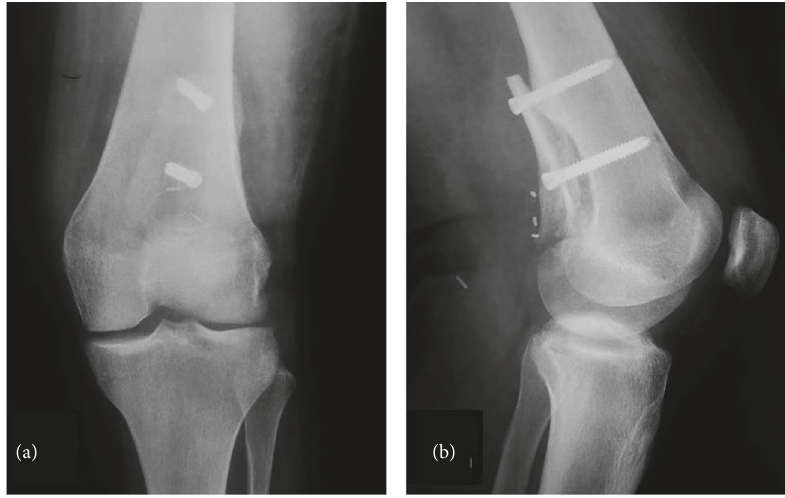
Figure 4: Anteroposterior (a) and lateral (b) radiographs 6months